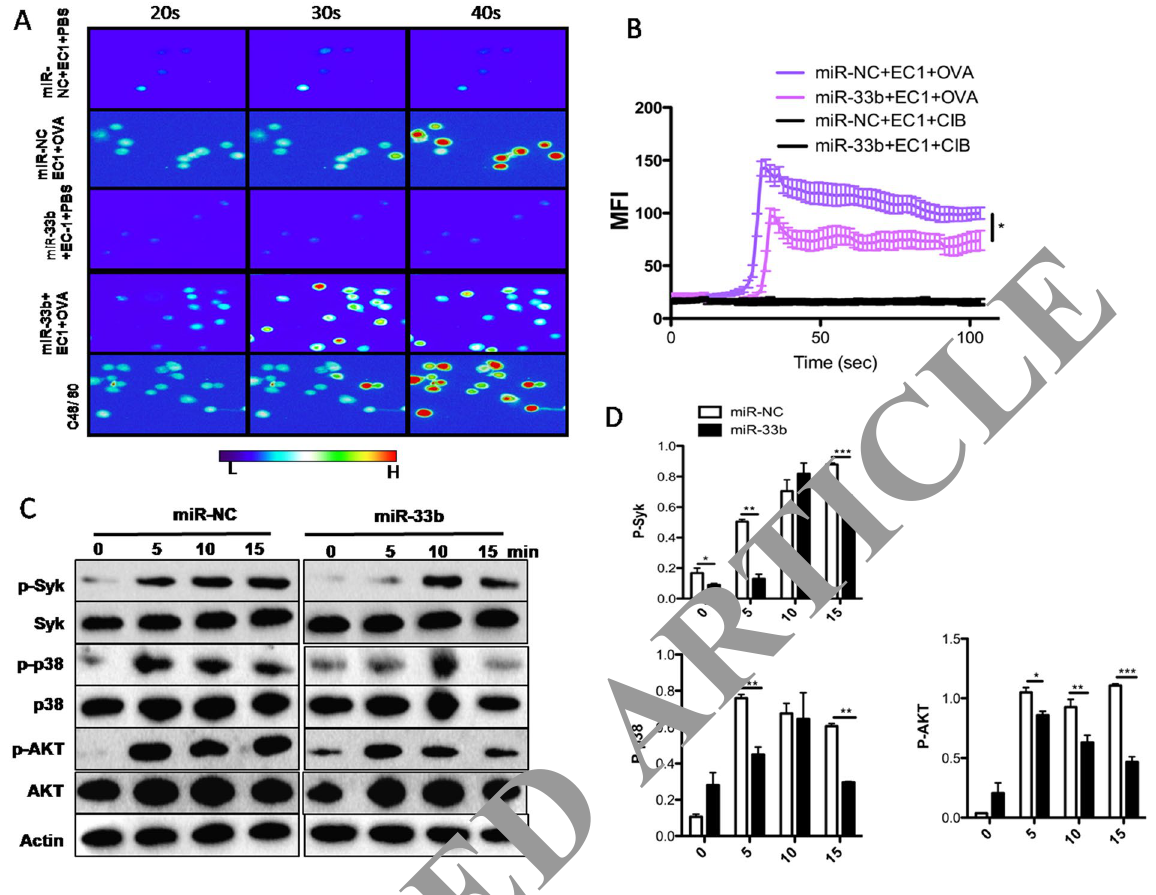
Figure 6. MiR-33b signaling events associated with mast cell function. ( A ) Representative Fluo-4 fluorescence heat map images of anti-OVA IgE-sensitized BMMCs showing the changes in [Ca 2 + ]i that were induced by OVA (n = 3). ( B ) Representative imaging traces. Each colored line represents the average of the traces for each treatment. CIB: Ca 2 + imaging buffer. ( C,D ) Representative immunoblot of IgE-initiated early and late signaling events in the miR-NC or miR-33b transfected BMMCs. The quantitative data are representative of 3 independent experiments. The data are the means ± SEM. * P < 0.05. ** P <